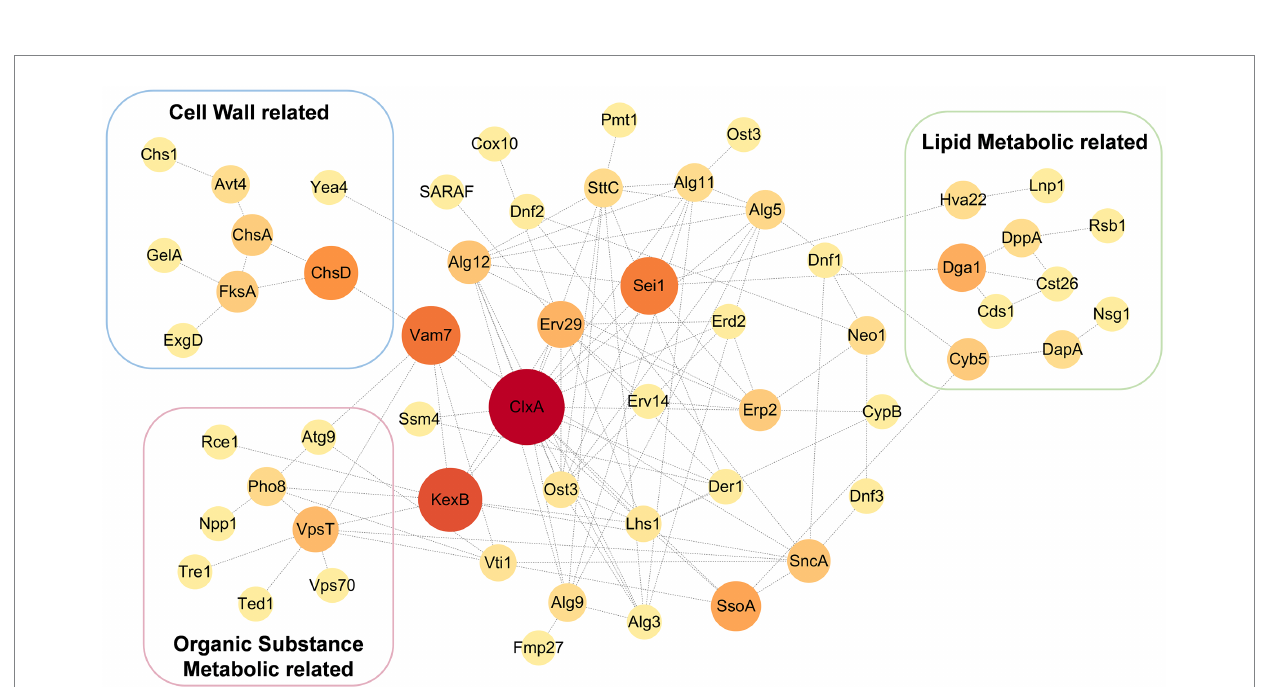
FIGURE 6 Predicted protein–protein interaction network of down-regulated membrane proteins in the DEL-Erv14 strain. The prediction was performed by STRING [STRING: functional protein association networks (string-db.org)] and exported into Cytoscape for further annotation. The size and color of the bubbles were determined by betweenness centrality (BC).